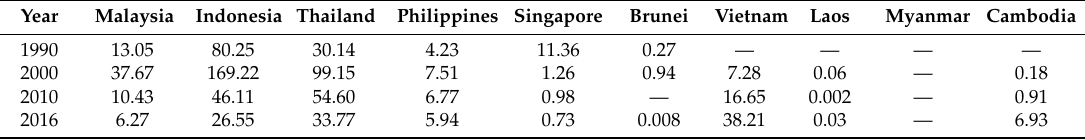
Table 5. Value of UK textile materials imports from ASEAN (unit: dollars in